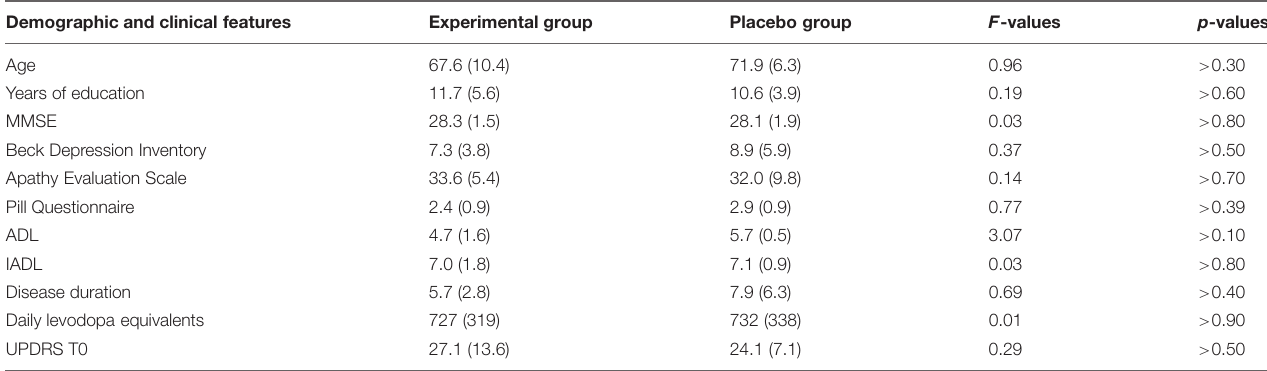
TABLE 1 | Clinical and sociodemographic characteristics of the PD patients included in the study. Demographic and clinical features